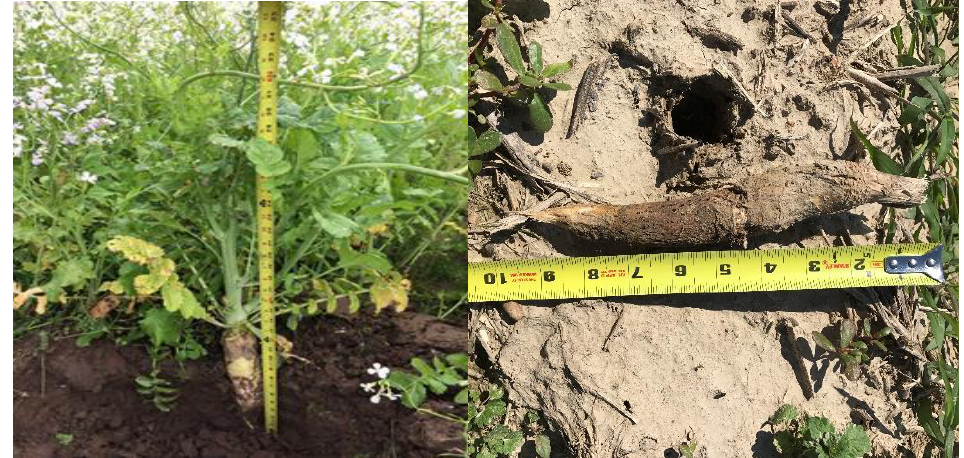
Figure 2. Tillage Radish cover crop in 2016 – 2017 winter season. Left: Biomass above ground surface and the root below ground surface. Right: Decomposed roots after the crop was killed for planting cotton.